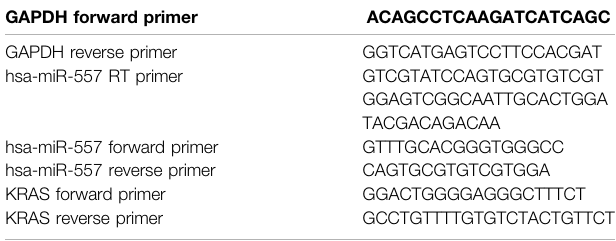
TABLE 1 | Primers used in qPCR.